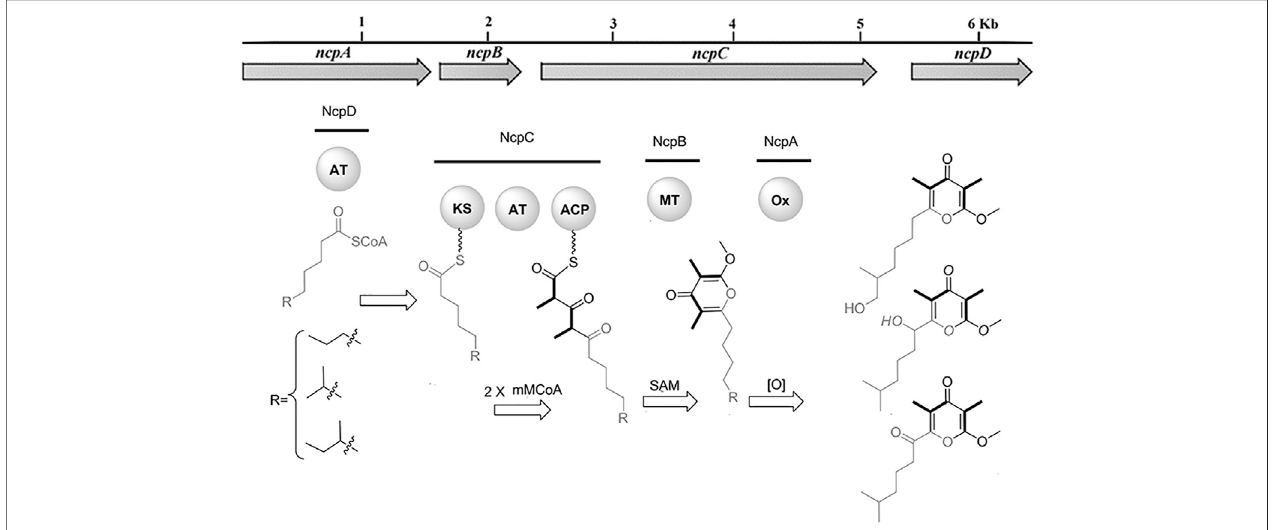
FIGURE 6 | Bacterial biosynthesis of nocapyrones. A genetic locus in Nocardiopsis sp. bacteria is responsible for producing ion channel modulators found in the whole snails, C. rolani and C. tribblei . Bold wedges within chemical structures indicate incorporation of methylmalonate. Figure from Lin et al. (2013).